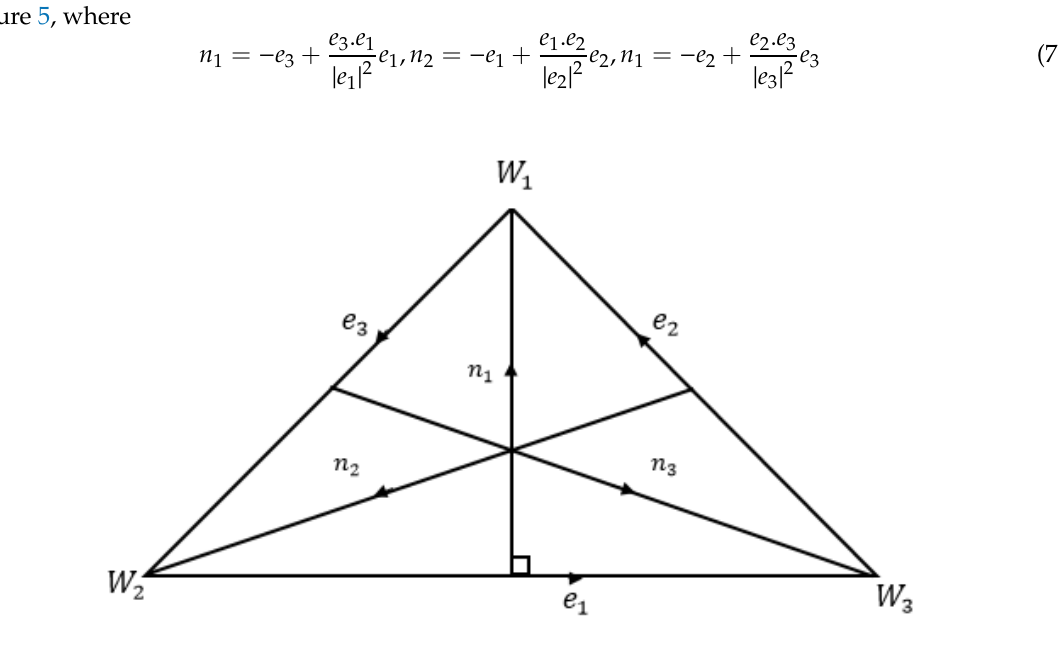
Figure 5. Inward normal direction to the edges of triangle.